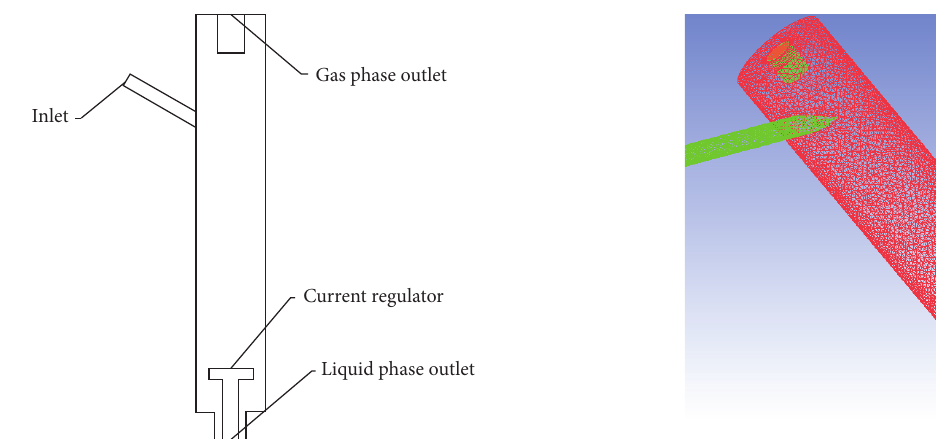
Figure 2: The grid distribution diagram of the cylindrical liquid-gas